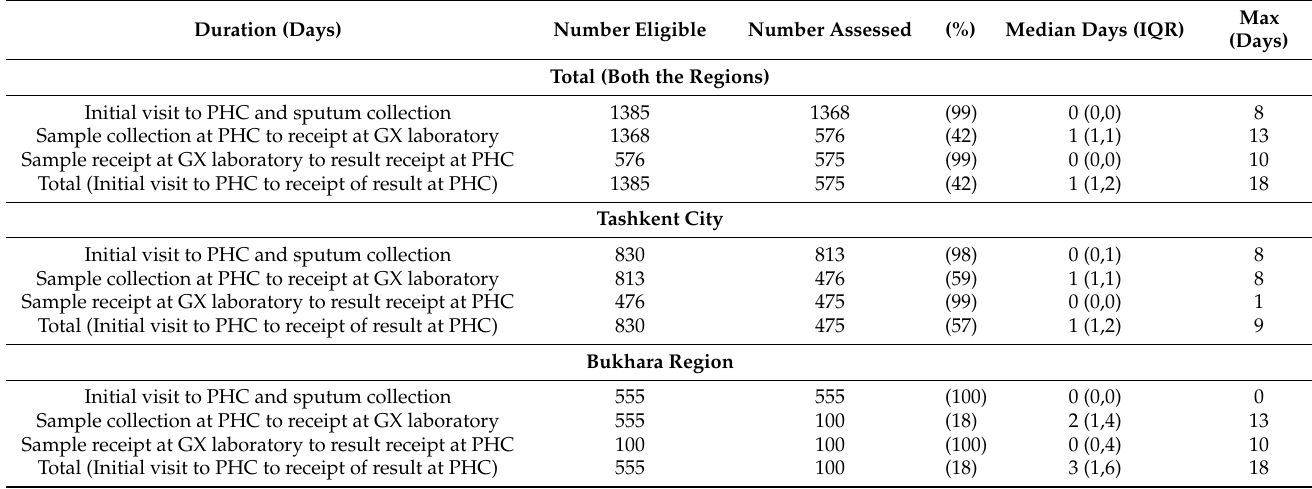
Table 5. Delays in Xpert MTB/RIF testing among presumptive tuberculosis patients in selected primary health centers (without Xpert testing services) of Tashkent City and Bukhara region of Uzbekistan, January–March